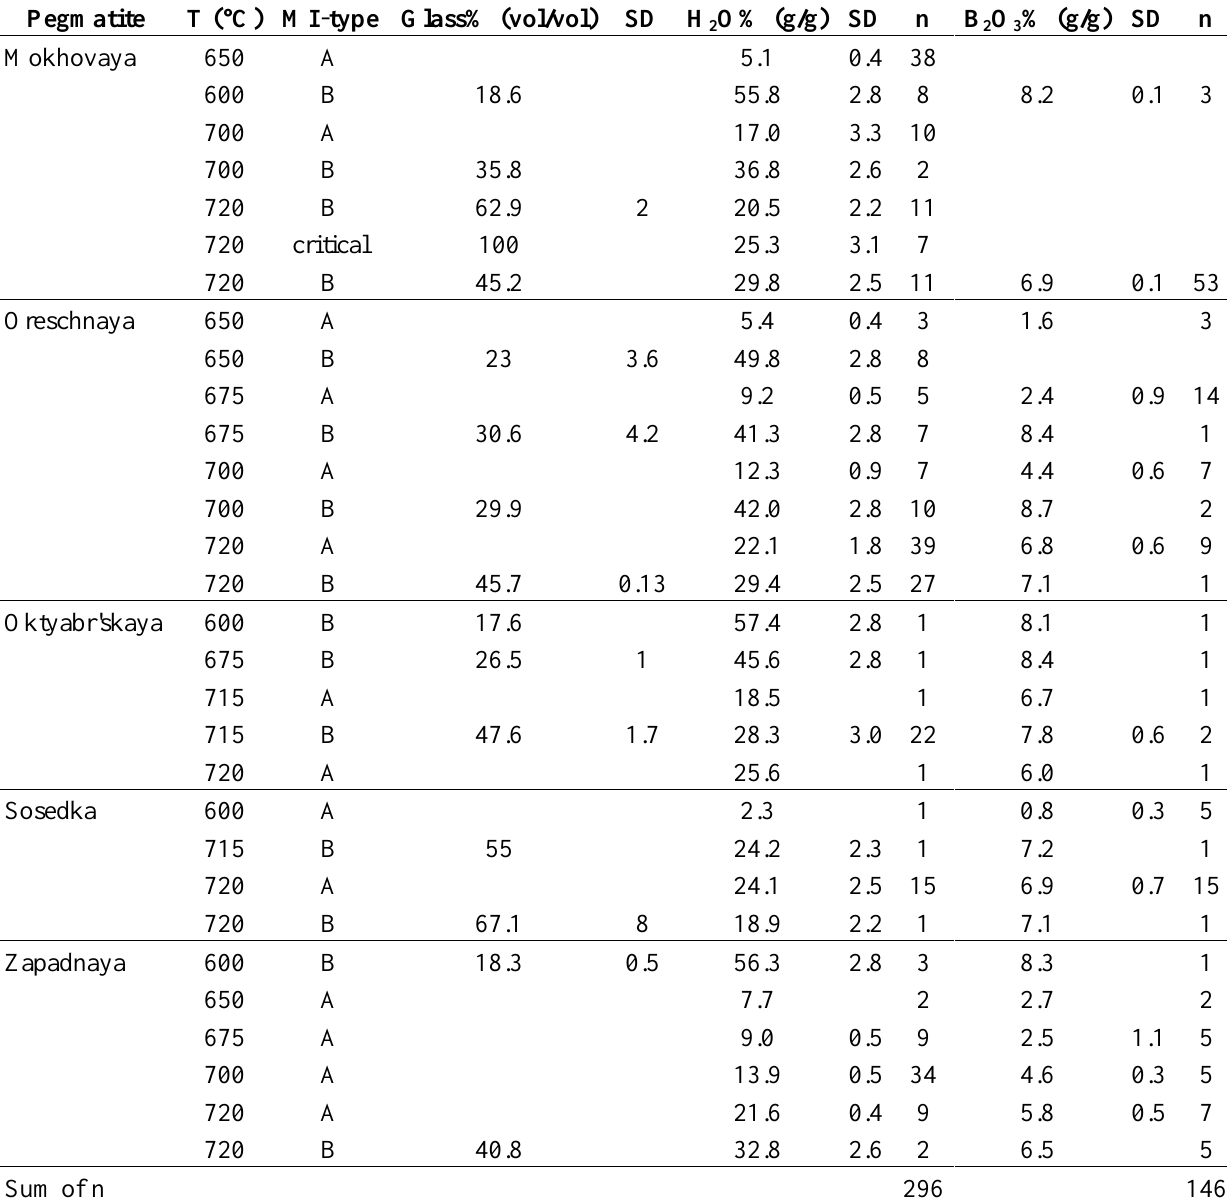
Table 2. Water and boron concentration in melt inclusions in quartz of the Malkhan pegmatite. Boron was determined using the microprobe technique and water by Raman spectroscopy and volumetric measurements (see [8]) in the case of type-B melt inclusions.